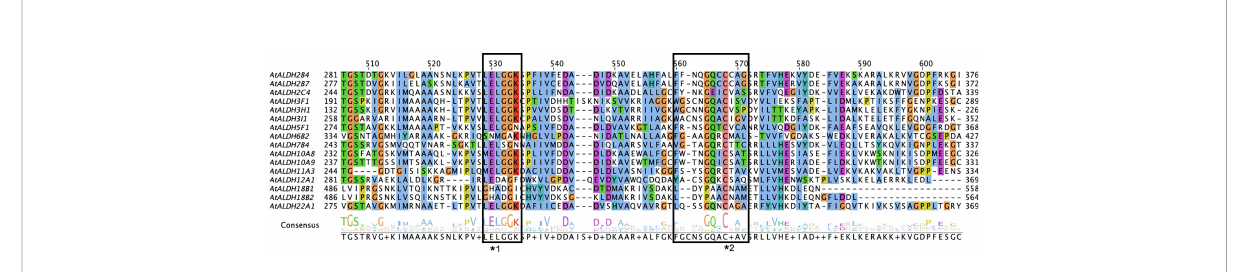
FIGURE 1 Multiple sequence alignments of the ALDH domain of all 16 AtALDH proteins. All 16 AtALDH protein sequences were analysed, the boxes represent conserved active sites for AtALDH proteins. *1 indicates a glutamic acid active site (PS00687) and *2 indicates a cysteine acid active site